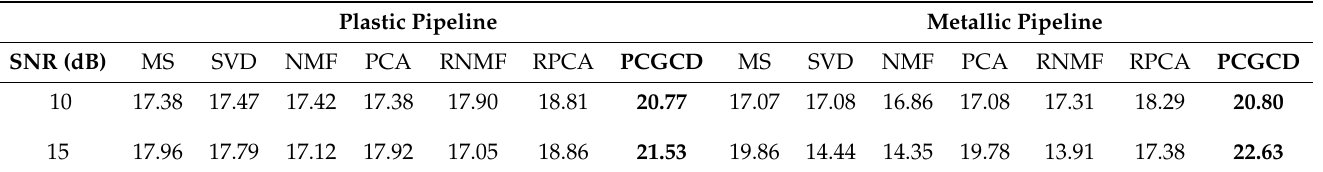
Table 5. The average of PSNR (dB) results with different